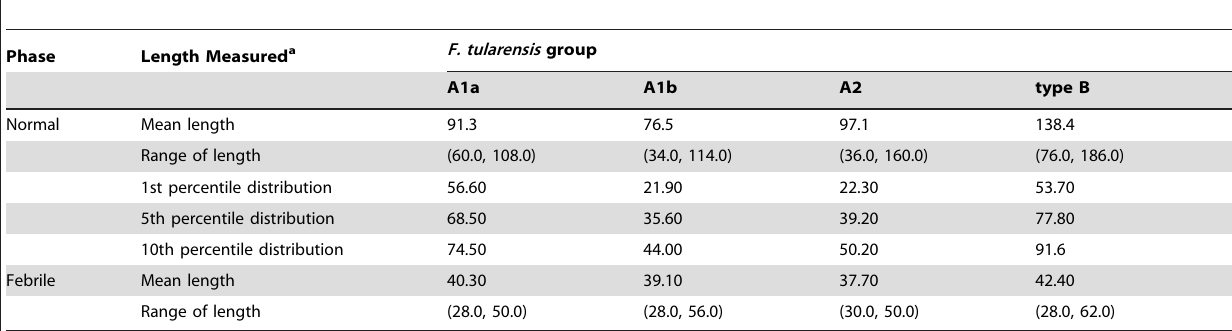
Table 1. Length of infection phase for mice infected with each F. tularensis group (A1a, A1b, A2 and type B).